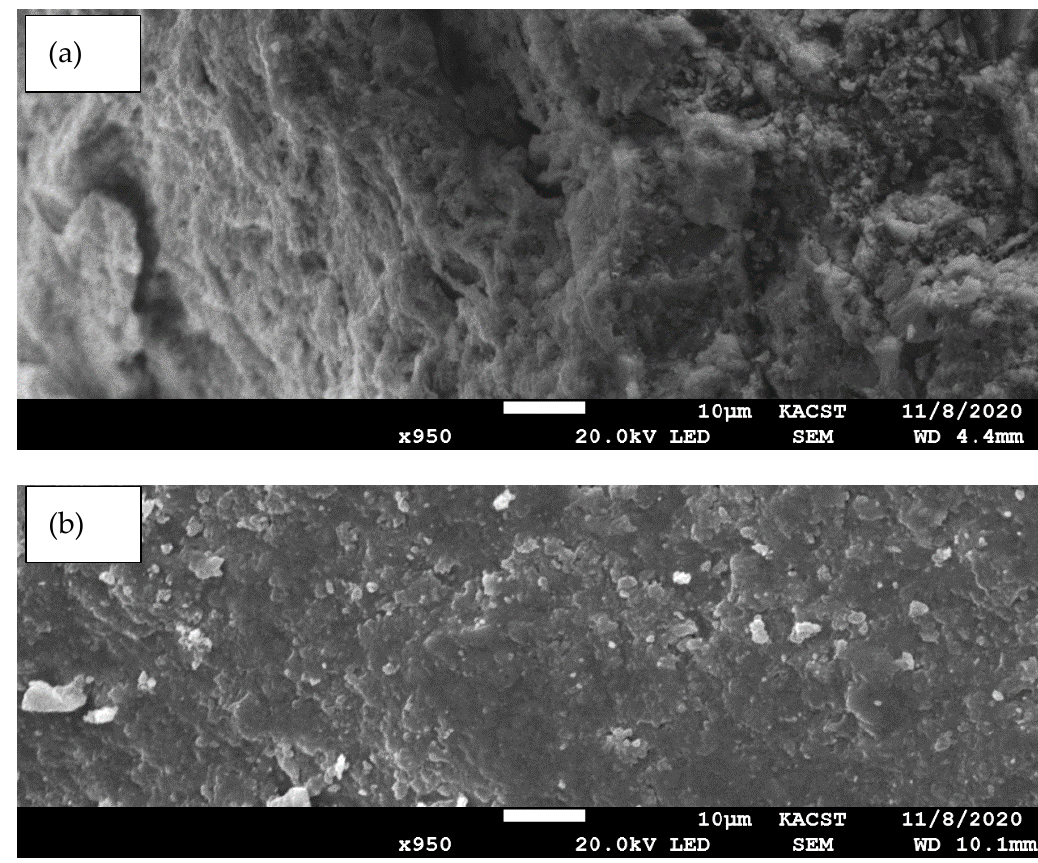
Figure 5. SEM of the tubular ceramic membrane: ( a ) cross-section of the membrane and ( b ) the top view of the membrane.